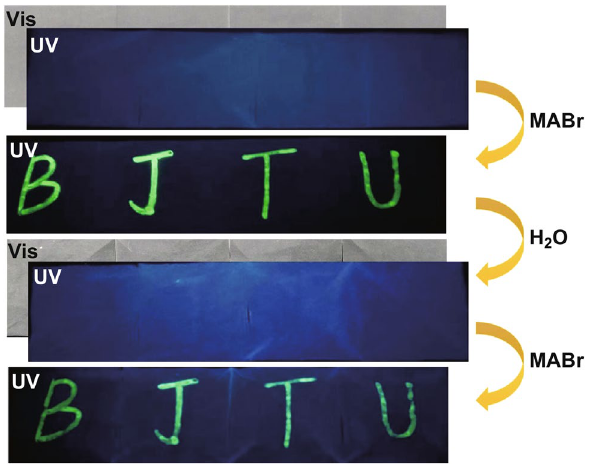
Fig. 27 Reversible fluorescence switching of the BJTU pattern writ- ten on the paper at different stages under ambient and 365 nm UV light. Reprinted with permission from Ref. [43]. Copyright 2019,